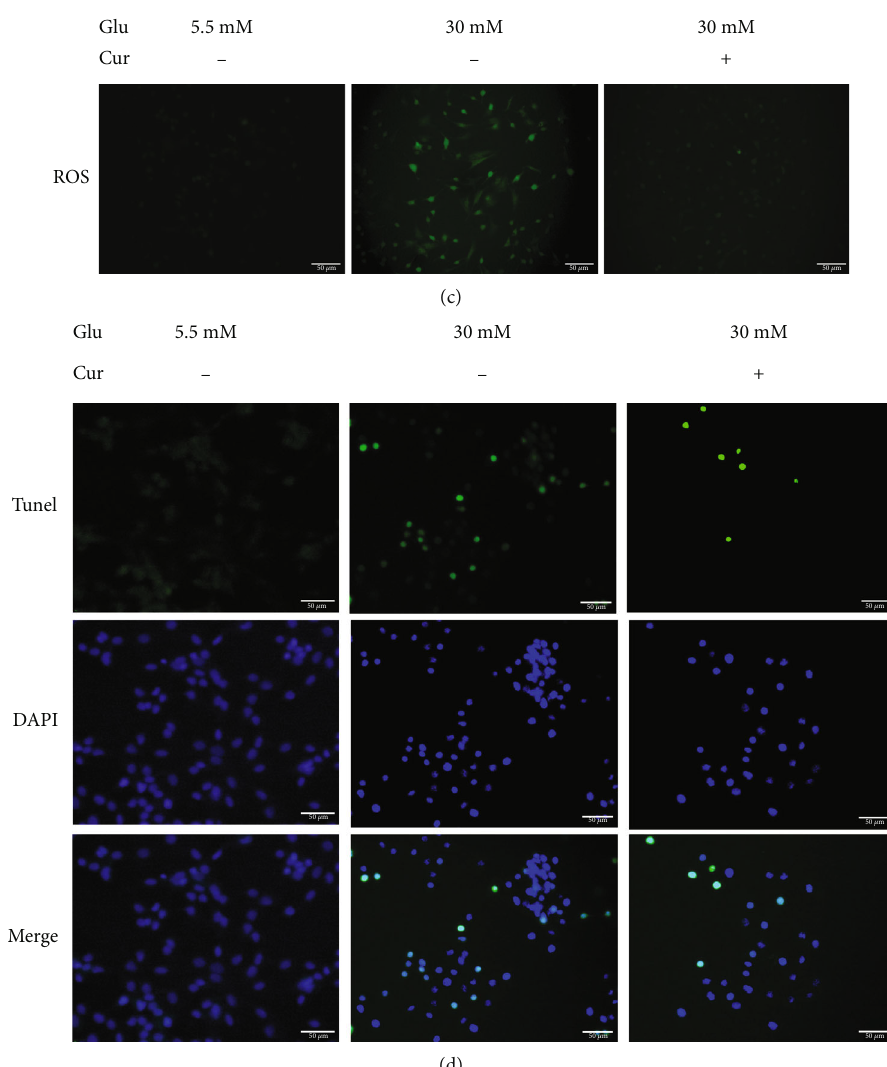
Figure 2: Curcumin-reduced pyroptosis induced by a high-glucose environment. Glu: glucose; Cur: curcumin; the dose of curcumin used in cell experiments is 14 μ M. (a) The expression levels of related proteins in the pyroptotic pathway were detected by western blotting. (b) The expression level of NLRP3 in cardiomyocytes was detected by immuno fl uorescence (40x). (c) The levels of reactive oxygen species (ROS) in cardiomyocytes of each group were detected by ROS fl uorescent probing (20x). (d) The apoptosis level of cardiomyocytes in each group was detected by TUNEL fl uorescent probing (20x). ∗∗ P < 0 : 001 , high-glucose group vs. normal group and curcumin-treated group. Values are expressed as the mean ± standard